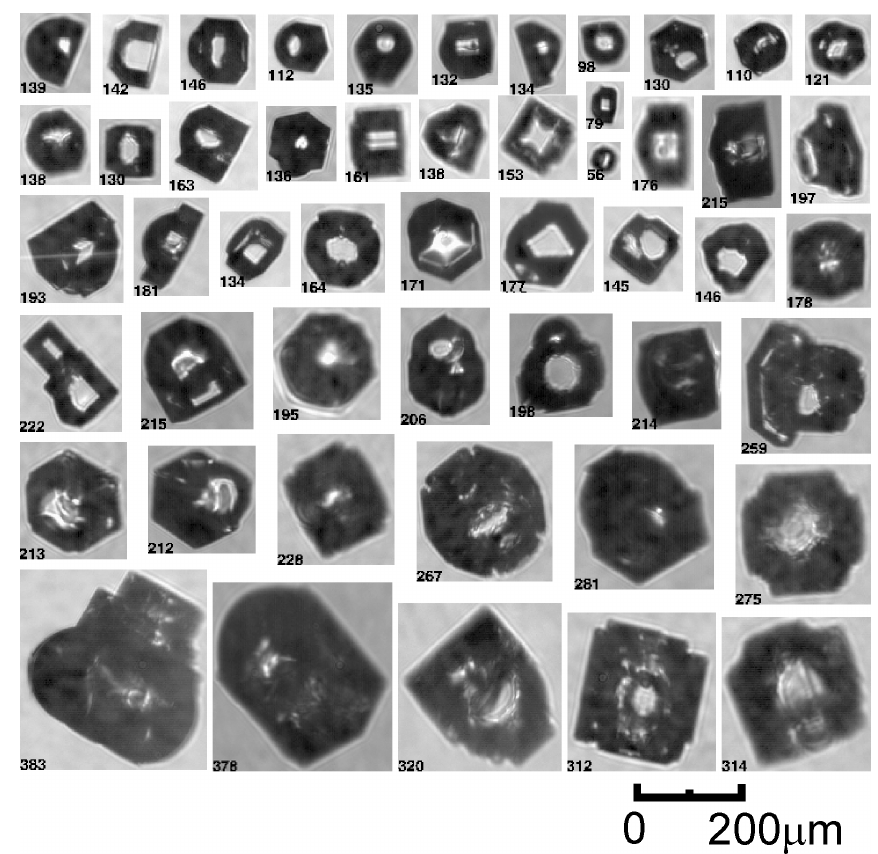
Figure 21. Images of frozen droplets partially regrown into faceted ice crystals in the range of − 5 ◦ C < T a < − 1 ◦ C.